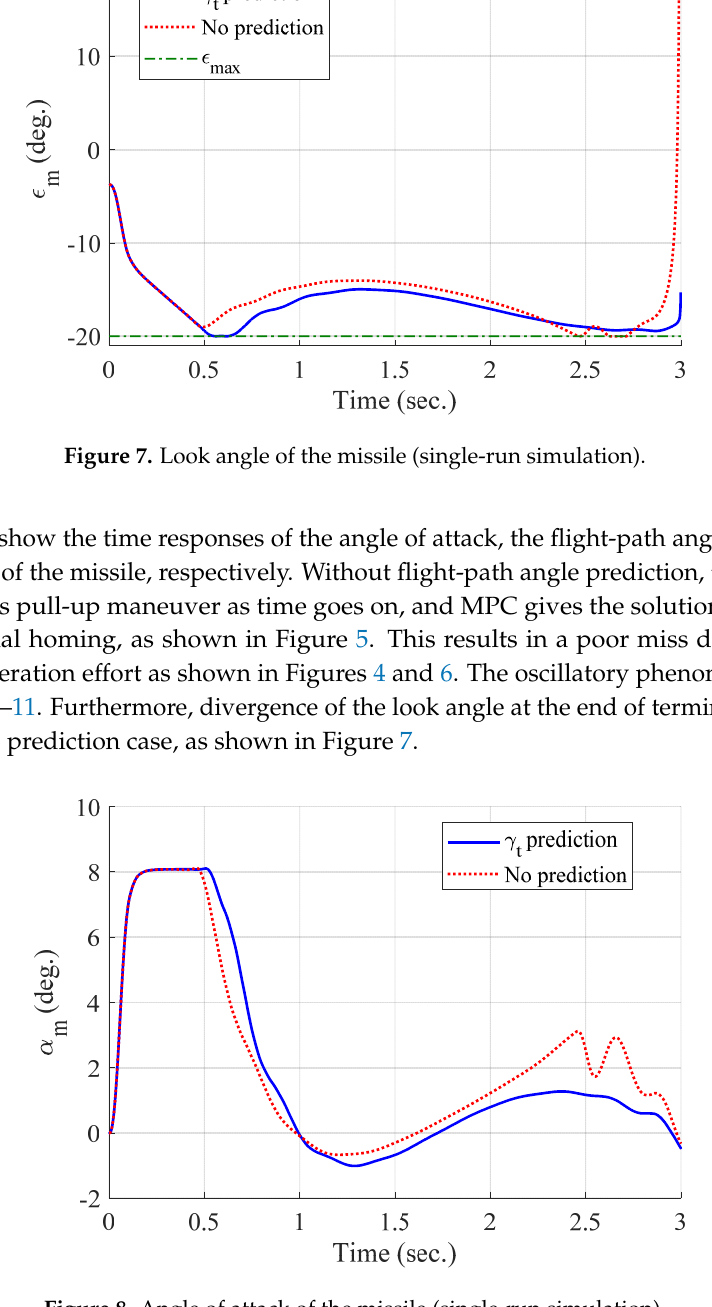
Figure 8. Angle of attack of the missile (single-run